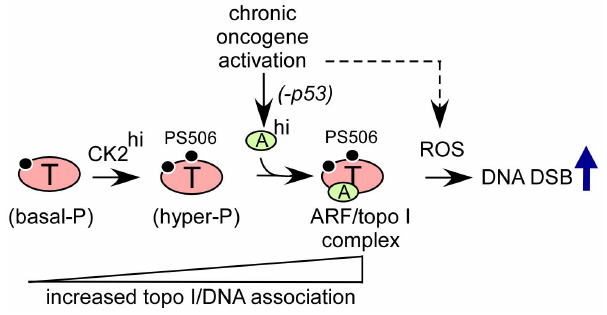
Figure 5. Model summarizing how oncogene-induced ARF expression and CK2-mediated topo I hyperphosphorylation can converge to enhance topo I–DNA association and topo I- facilitated DNA damage. Cancer cells with elevated CK2 levels (CK2 hi ) accumulate a PS506-hyperphosphorylated form of topo I with increased DNA binding properties. Chronic oncogene activation in the absence of wild-type p53 leads to sustained elevation of ARF (ARF hi ), which is unable to promote p53-mediated apoptosis but is available to bind to PS506-hyperphosphorylated topo I, further promoting the association of topo I with DNA. The enhanced binding increases the potential for topo I-facilitated DNA double-strand break (DSB) formation in the presence of elevated levels of reactive oxygen species (ROS) that accompany oncogene activation.